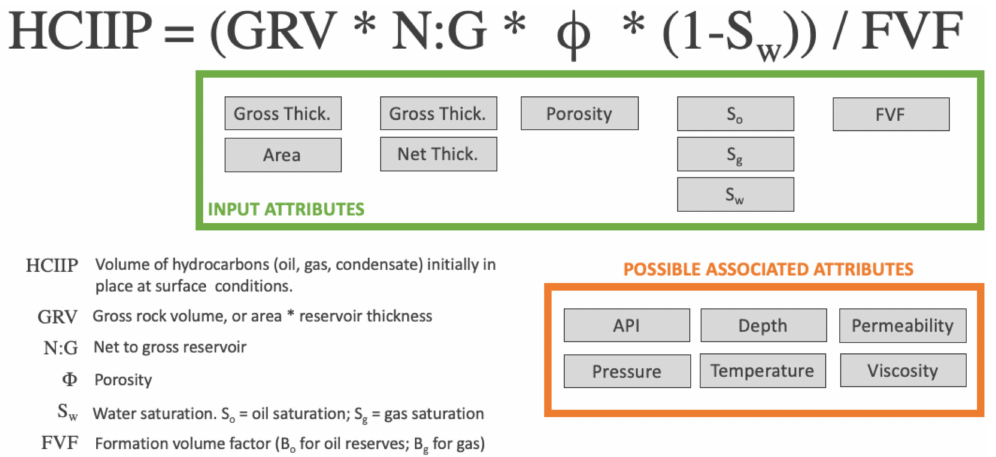
Figure 2. The Hydrocarbons Initially In Place (HCIIP) calculation and relevant attributes within the datasets. Primary attributes directly feed into the HCIIP calculation. Six additional attributes are identified as likely to show some dependency to the HCIIP